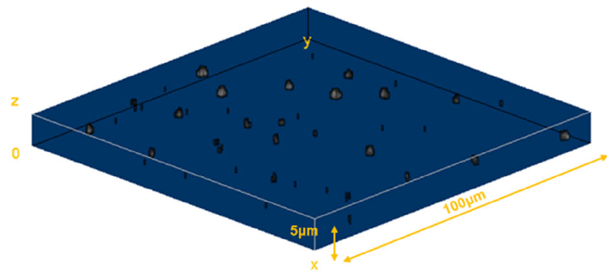
Figure 5. Three ‐ dimensional reconstruction of a CLSM image.